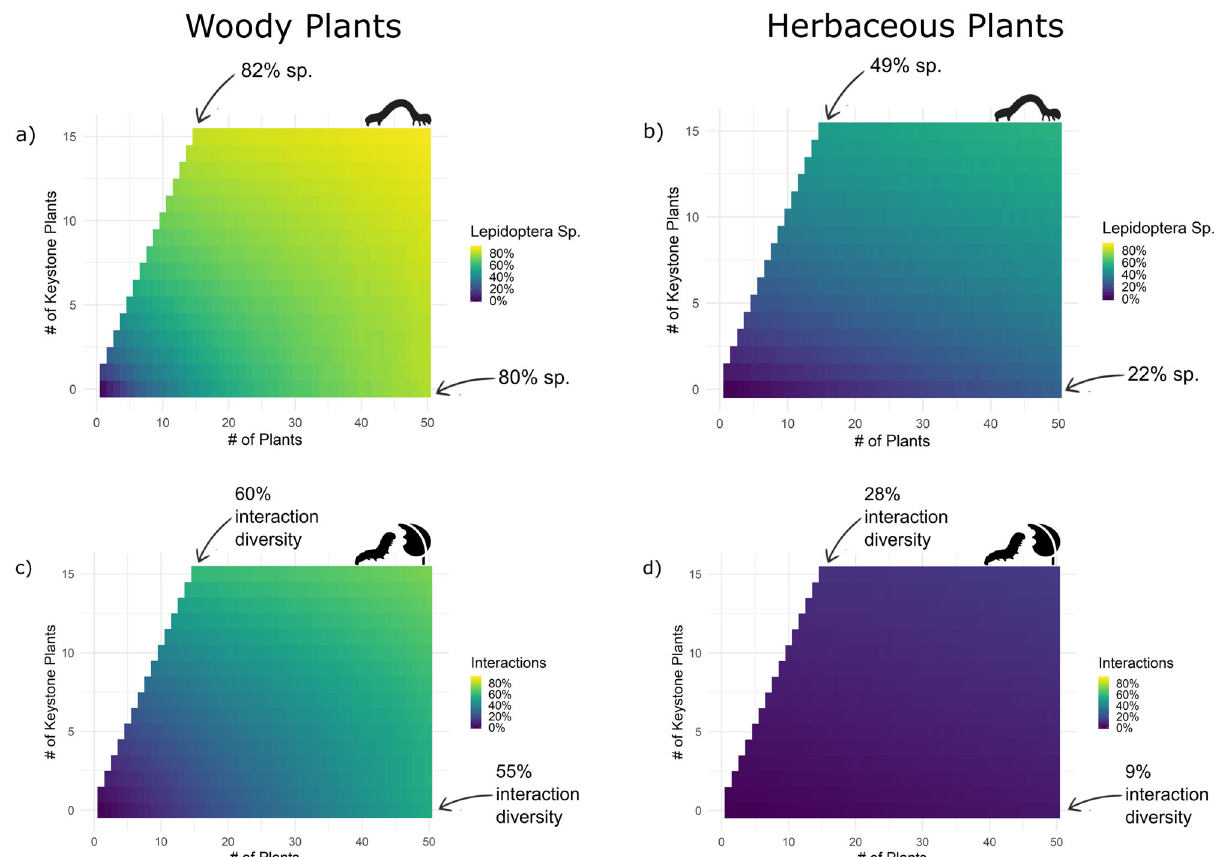
Fig. 3 Including woody and herbaceous keystone plants increases the ef fi cacy and ef fi ciency of the restoration of Lepidoptera diversity. Simulations of restoration scenarios where ( a ) Lepidoptera diversity on woody plants, ( b ) Lepidoptera diversity on herbaceous plants, ( c ) interaction diversity on woody plants, and ( d ) interaction diversity on herbaceous plants as numbers of plant genera (x-axis) and keystone plant genera (y-axis) increase. For comparisons across counties, percent species and percent interactions from total possible is used in lieu of raw numbers. For both woody (left column) and herbaceous plants (right column), supported caterpillar species and interactions were higher with fewer plants when keystone plant species were included. In woody plants, more than twice the number of plant genera was required to achieve the species and interactions produced by keystone plants. In herbaceous plants, comparable richness and interactions were not reached even with a 3-fold increase in plant genera richness. Caterpillar icon in ( a , b ) from www. phylopic.org; caterpillar and leaf icons in ( c , d ) made by Freepik [https://www. fl aticon.com/authors/freepik] from www. fl